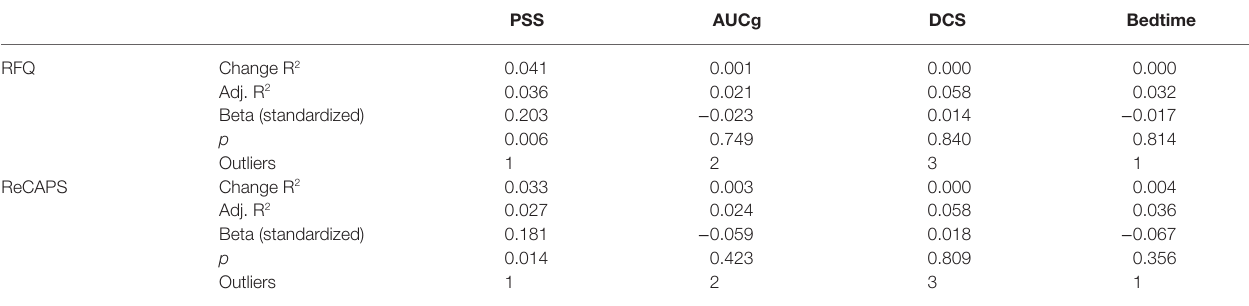
TABLE 3 | Adjusted regression analyses with RFQ and ReCAPS as predictors and PSS and cortisol indexes as dependent variable.